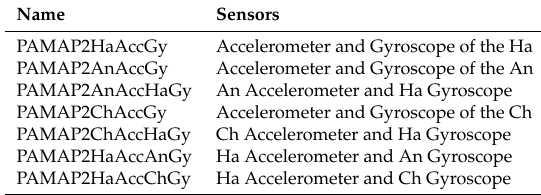
Table 2. Data sets obtained from the data of the IMUs of the PAMAP2 data